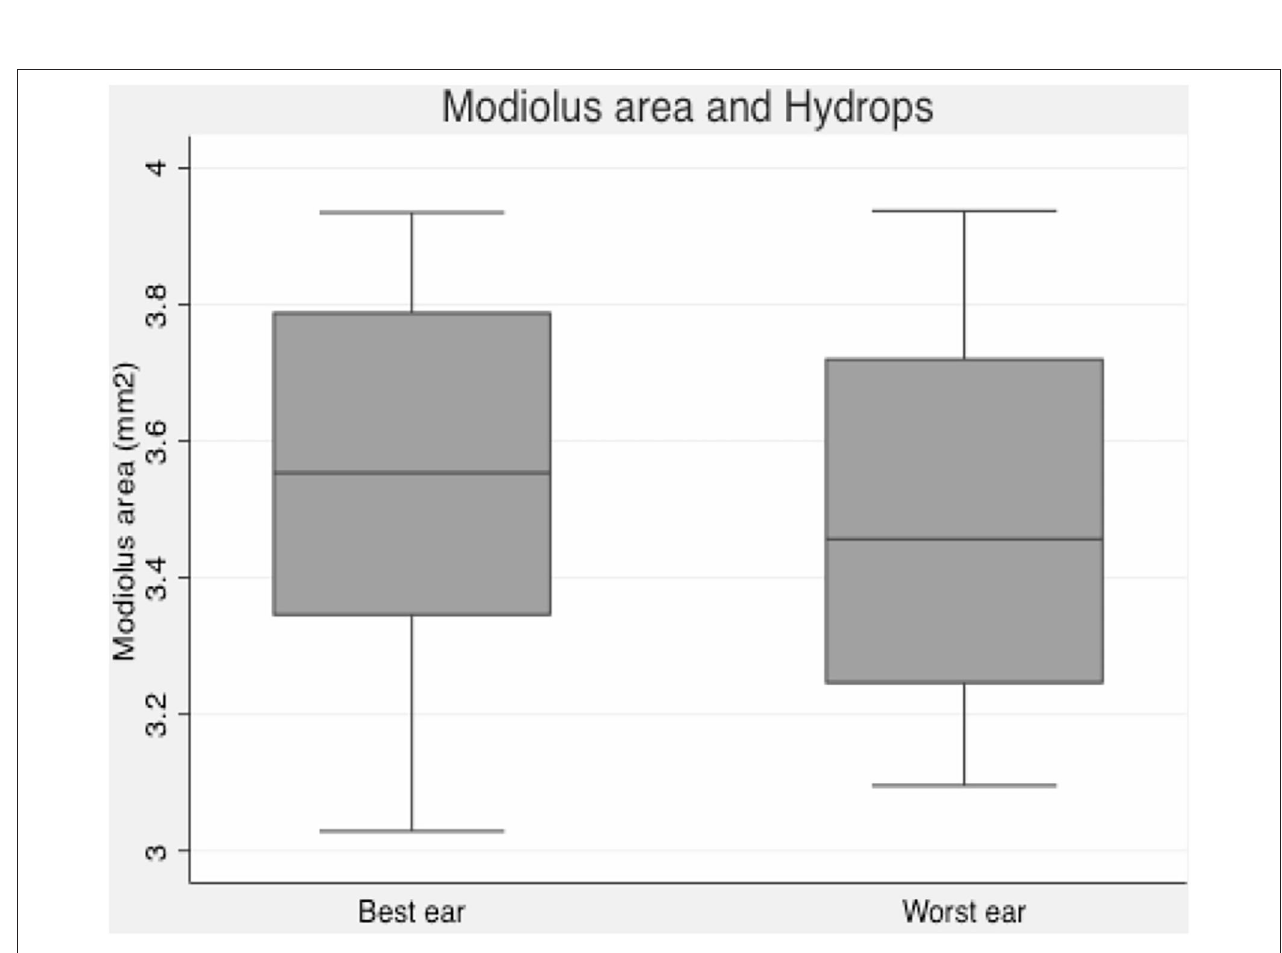
FIGURE 2 | Box plot graphic. Modiolus area and endolymphatic hydrops–slightly smaller modiolus in ears with more pronounced vestibular hydrops.